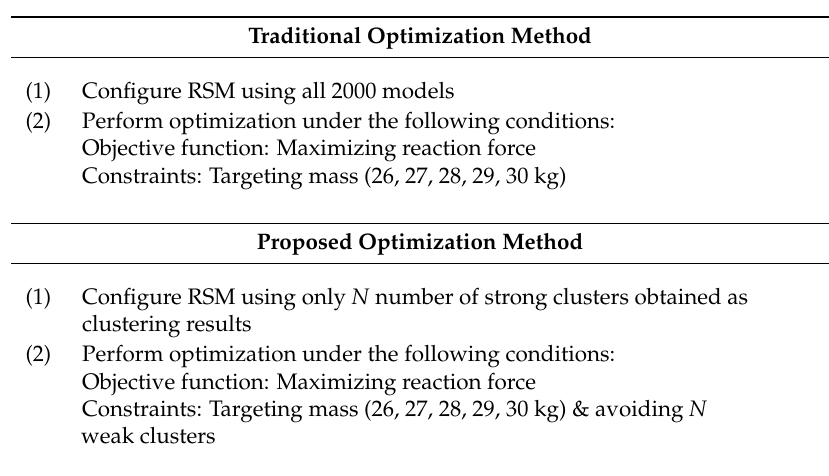
Table 5. Comparison of traditional and proposed optimization